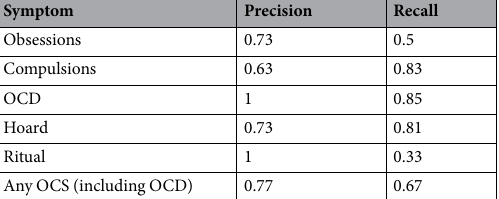
Table 3. Performance of individual components of the OCS algorithm in the validation set (300 documents) and the performance overall for detecting any OCS (including OCD) across all strings with Precision (positive predictive value) and recall (sensitivity)